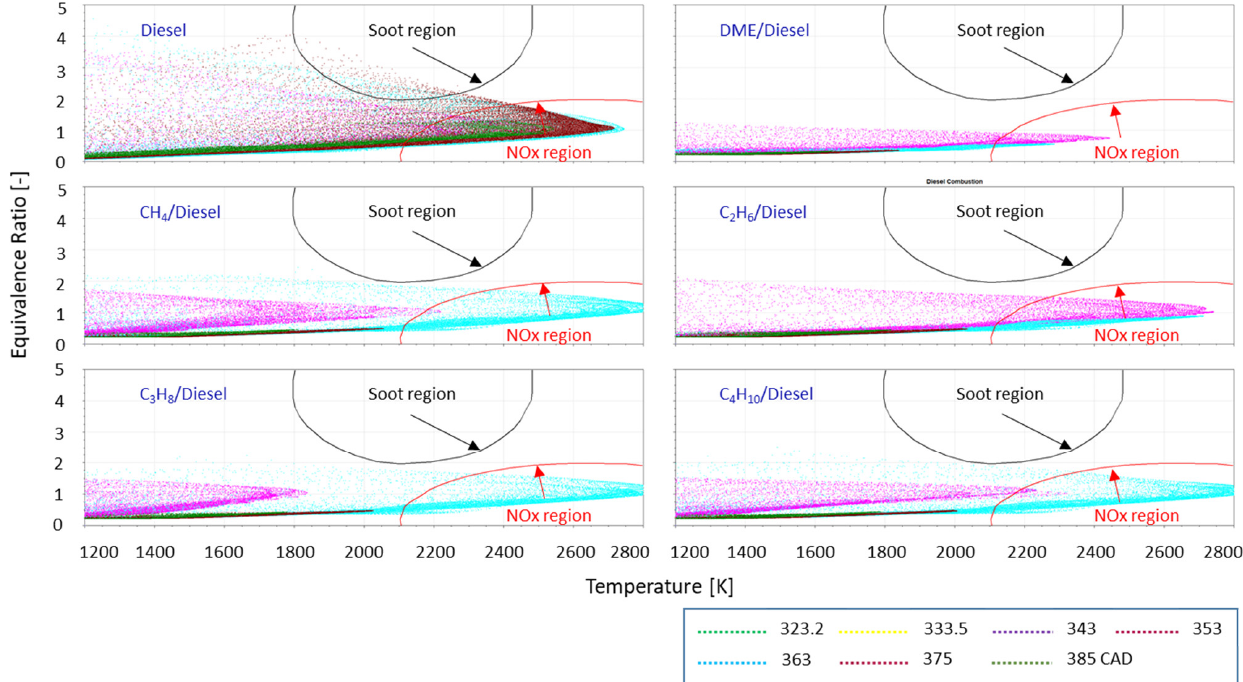
Figure 14. Equivalence ratio-temperature diagrams in all combustion cases